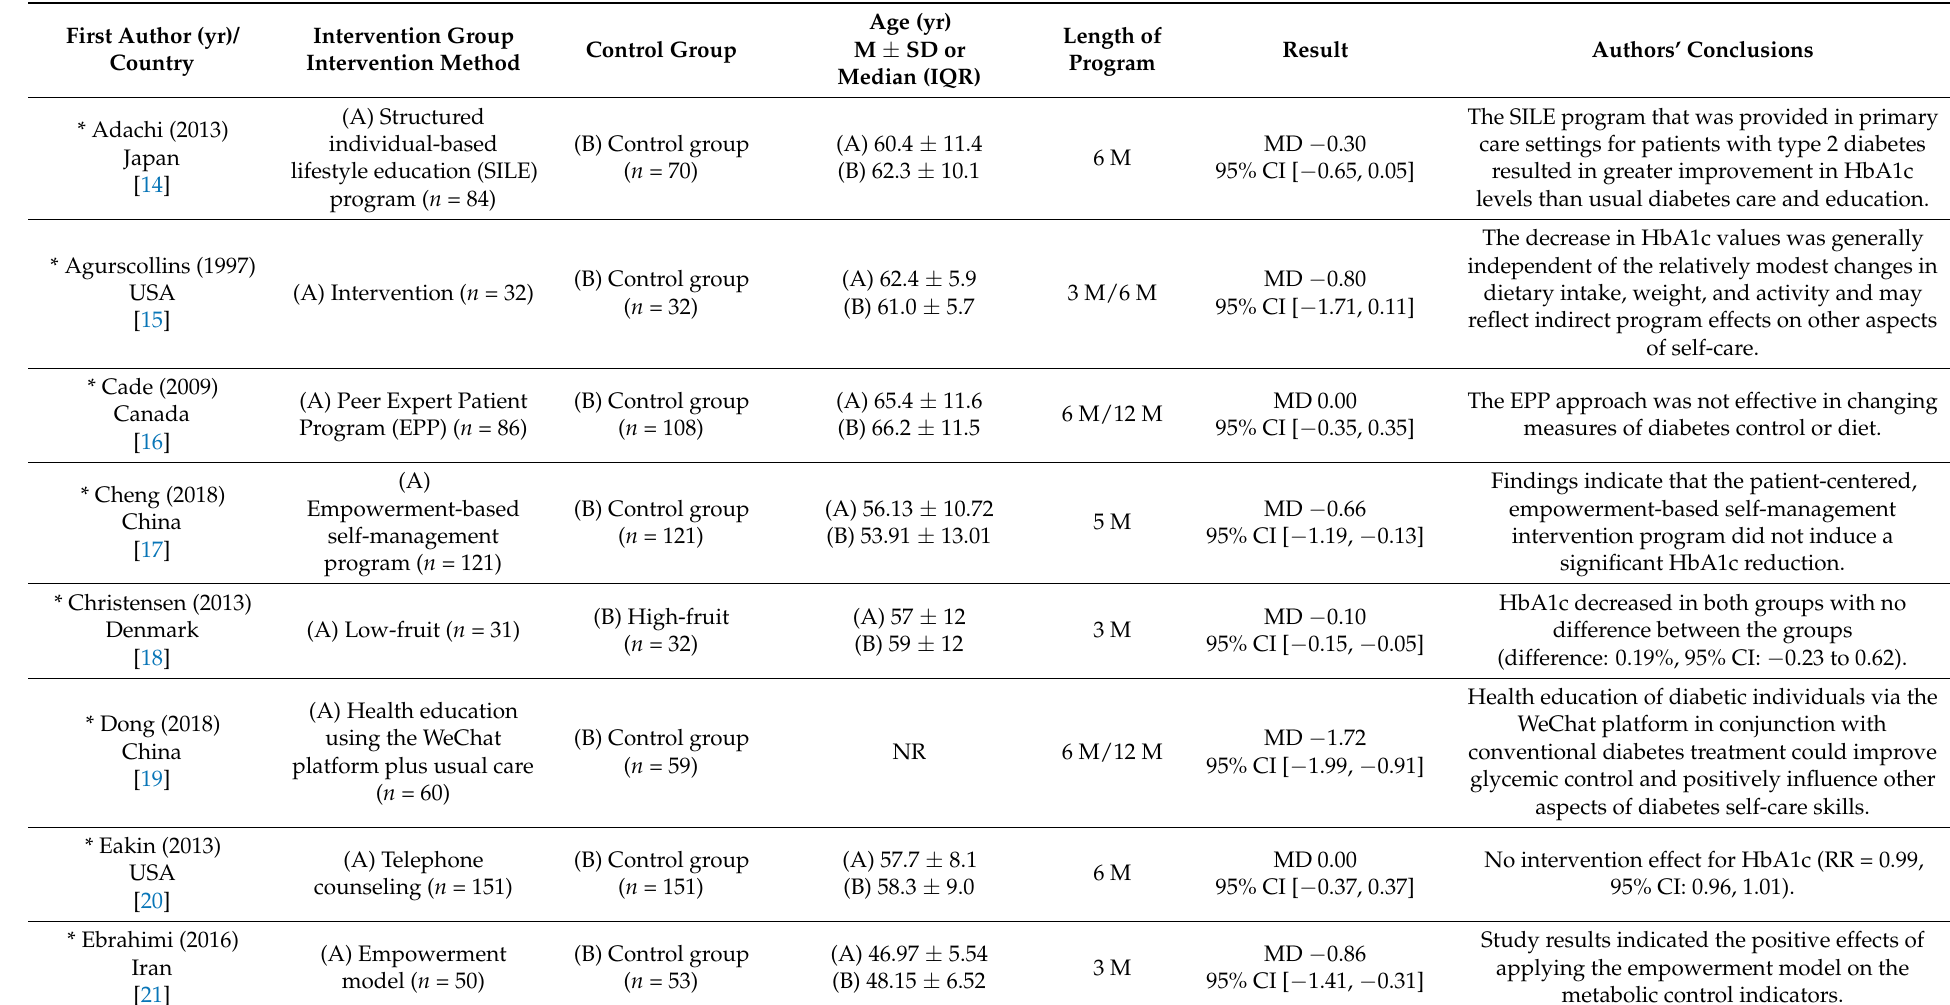
Table 1. Summary of randomized controlled trials on the effects of diet education for patients with type 2 diabetes